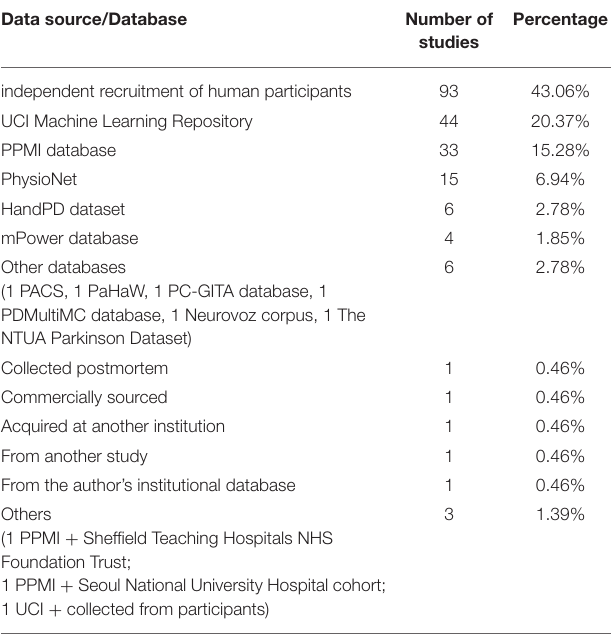
TABLE 2 | Source of data of the included